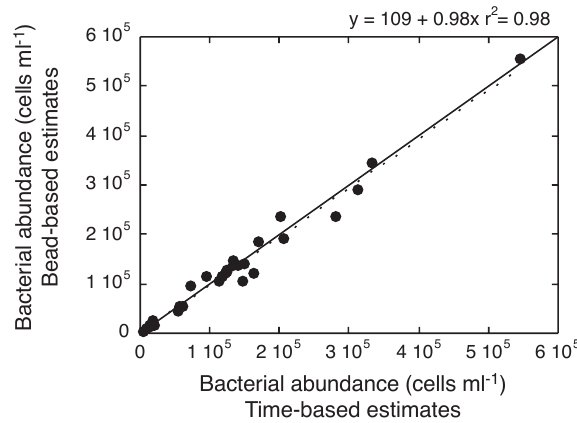
F IG . 3. – Comparison of bacterial concentrations obtained from the relationship of cells detected to the number of beads detected (the beads coming from a solution of known concentration added as internal standards: “bead-based”); and bacterial concentrations cal- culated from the sample delivery rate of the machine (calibrated gravimetrically at the beginning of the session: “time-based”).